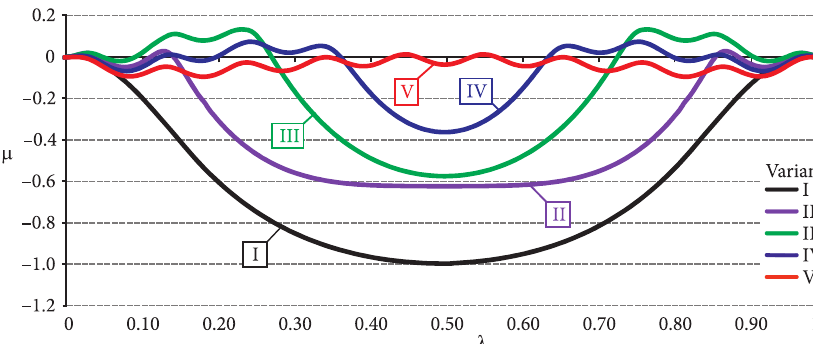
fig. 10. General distribution of relative bending moments (µ, from 0 to –1) along the raft central axis (λ, from 0 to